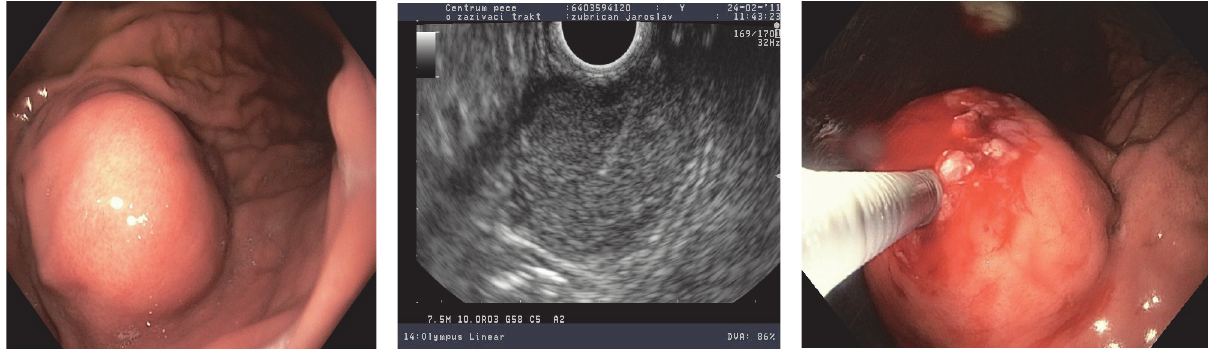
Fig. 2. Endosonography-guided aspira- tion.